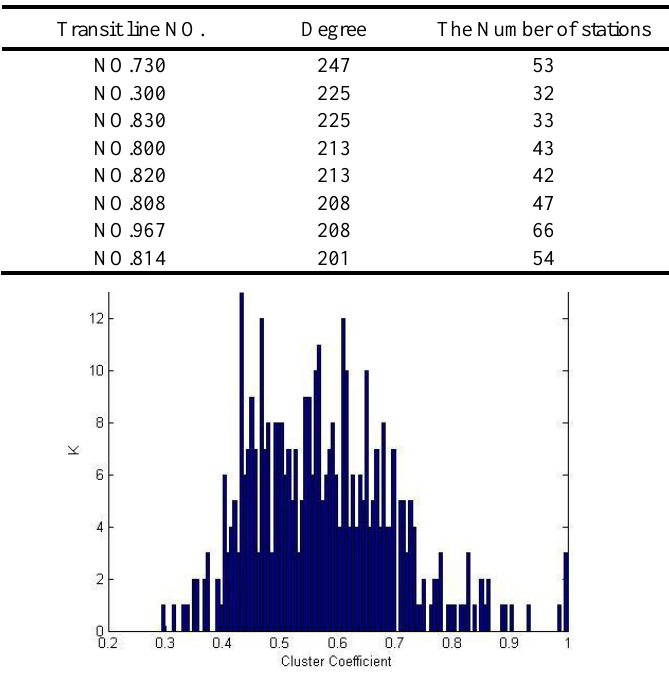
Fig.3 Histogram of clustering coefficient of the transit-line network.